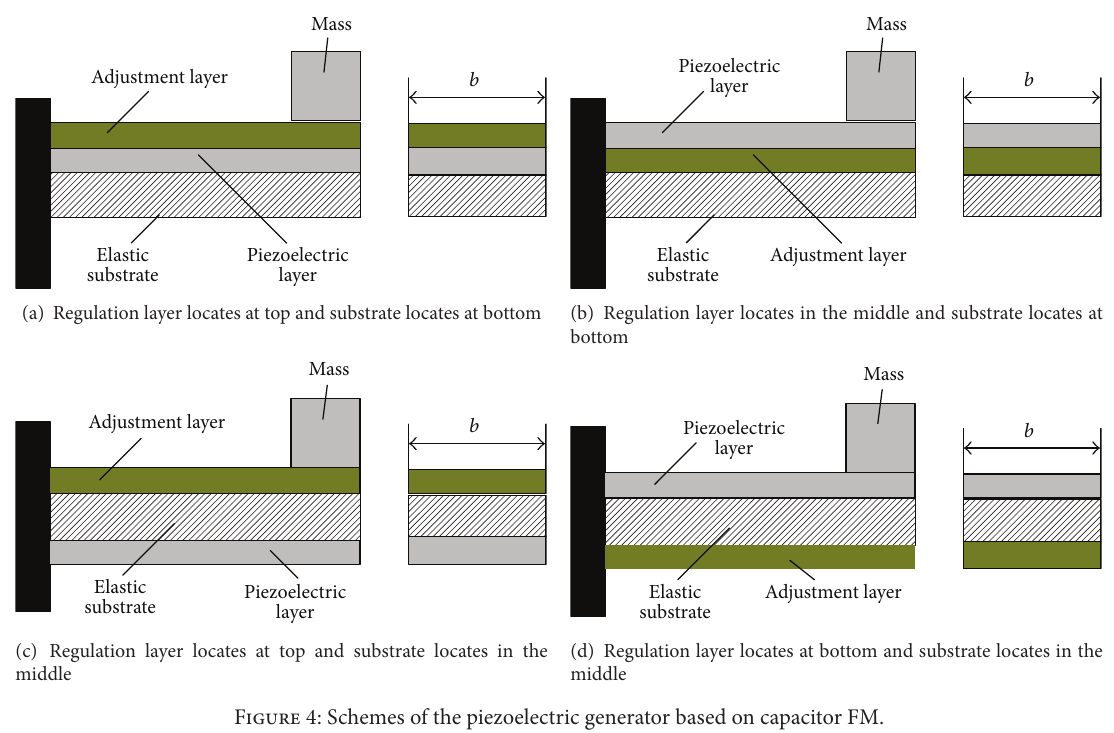
Figure 4: Schemes of the piezoelectric generator based on capacitor FM.